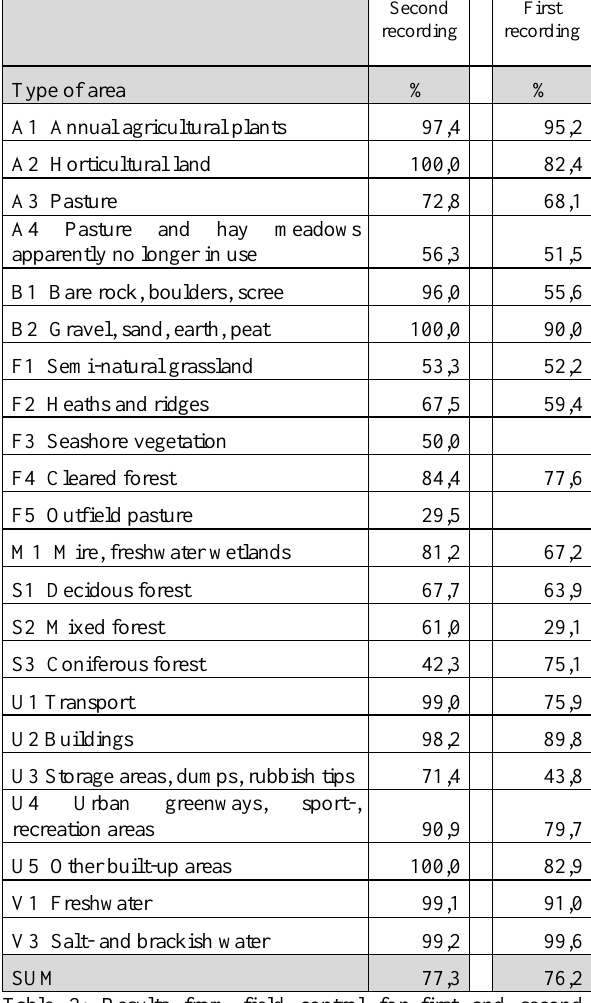
Table 2: Results from field control for first and second inventory